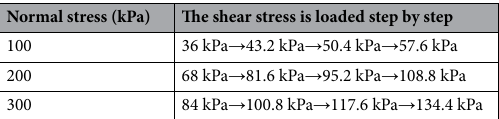
Table 2. Hierarchical loading scheme.